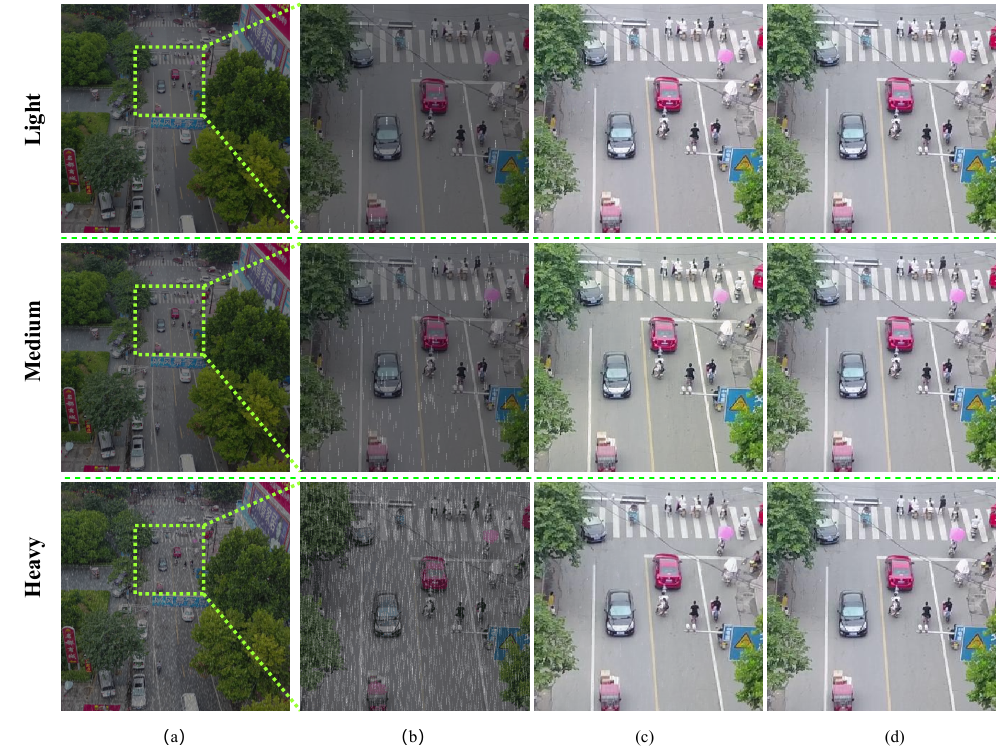
Figure 11. Visualization of images and patches reconstructed by Deraining Subnetwork. ( a ) The original input images. ( b ) The patches cropped from the original image. ( b ) The reconstructed rain-free patches. ( c ) The corresponding ground